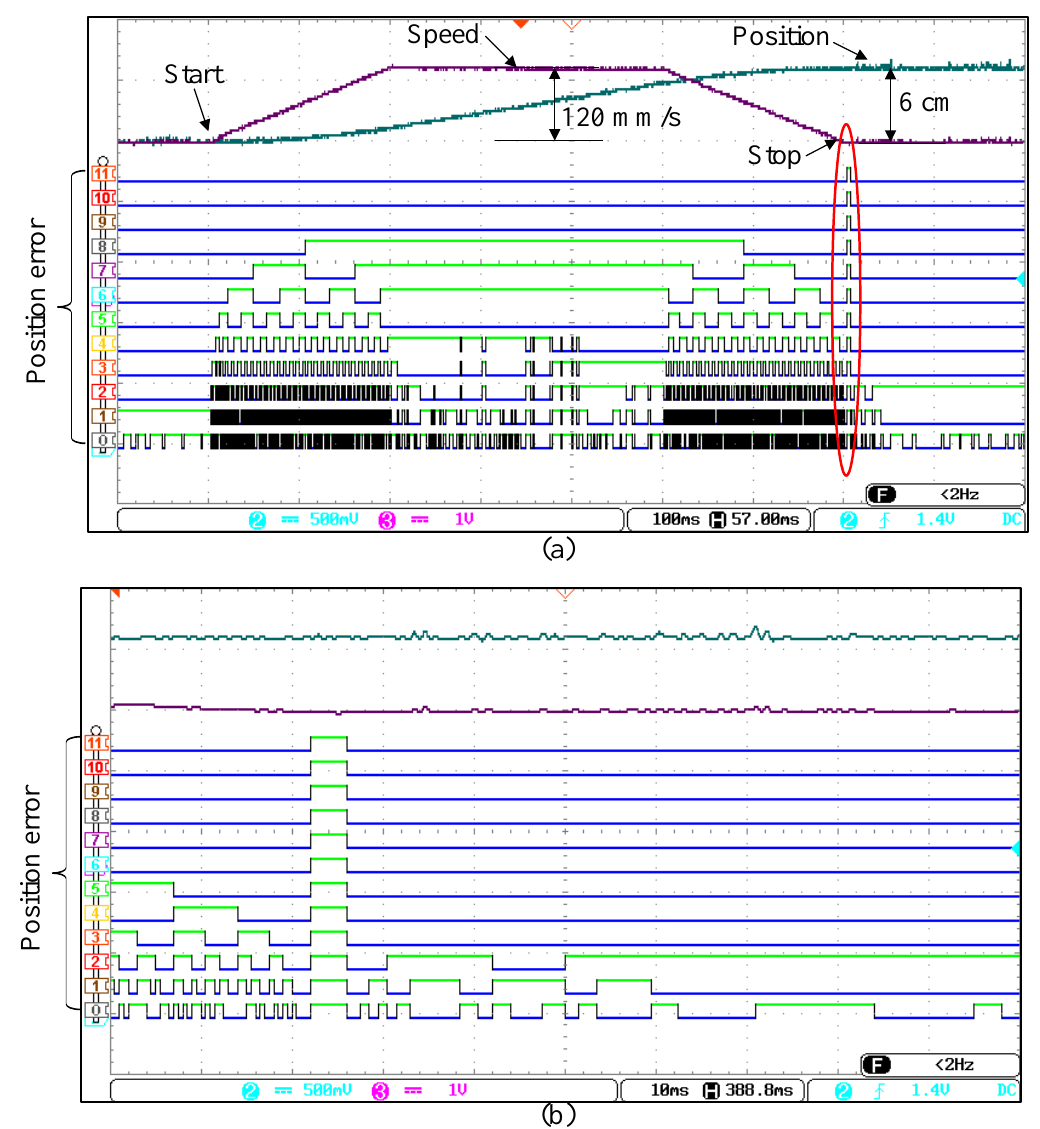
Figure 12. The experimental results without switching control. ( a ) The position, speed and position tracking error. ( b ) Zoom picture of ( a ). tracking error. ( b ) Zoom picture of ( a